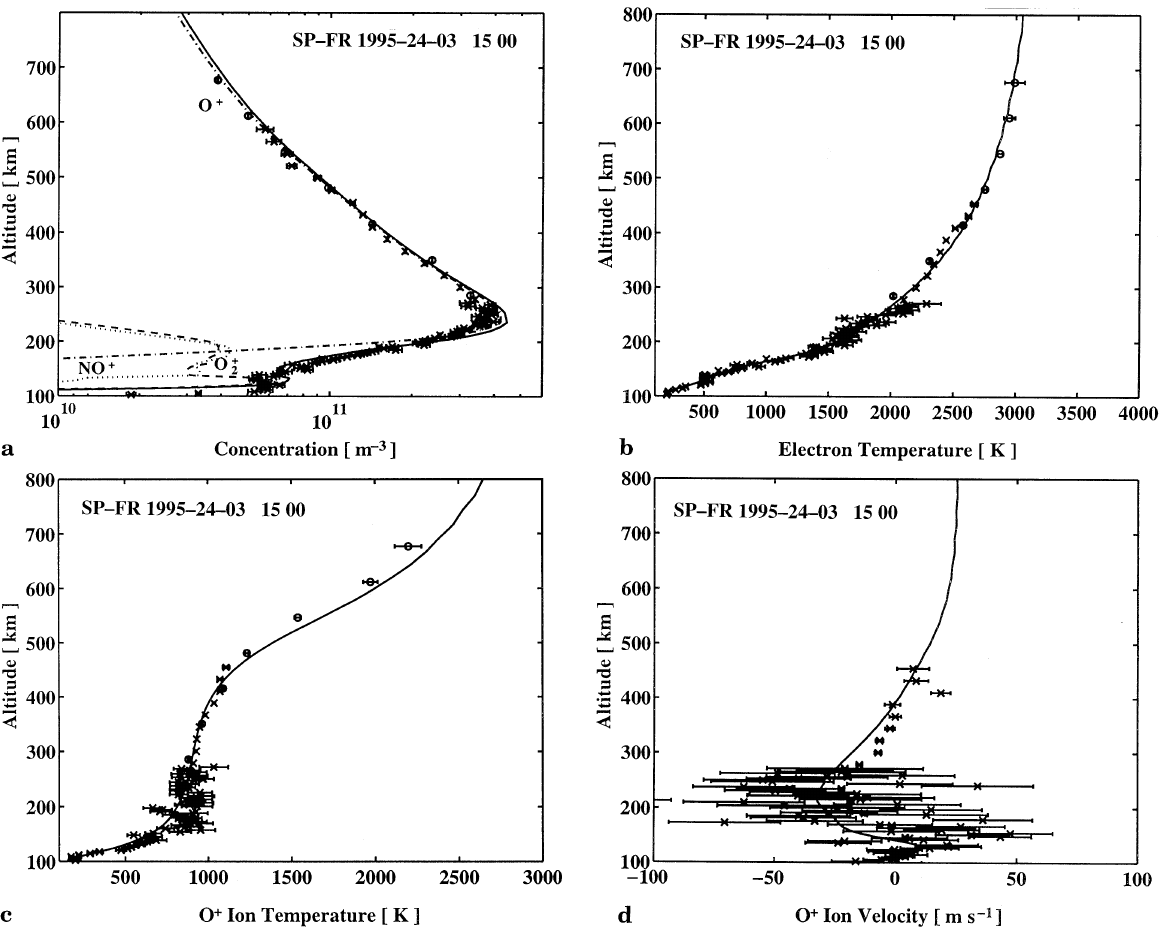
O (cid:96) ( dot - dashed line ), NO (cid:96) ( dotted line ) and O (cid:96) (cid:50) ( dashed line ) concen- tration profiles are plotted to give some indication on the composi-